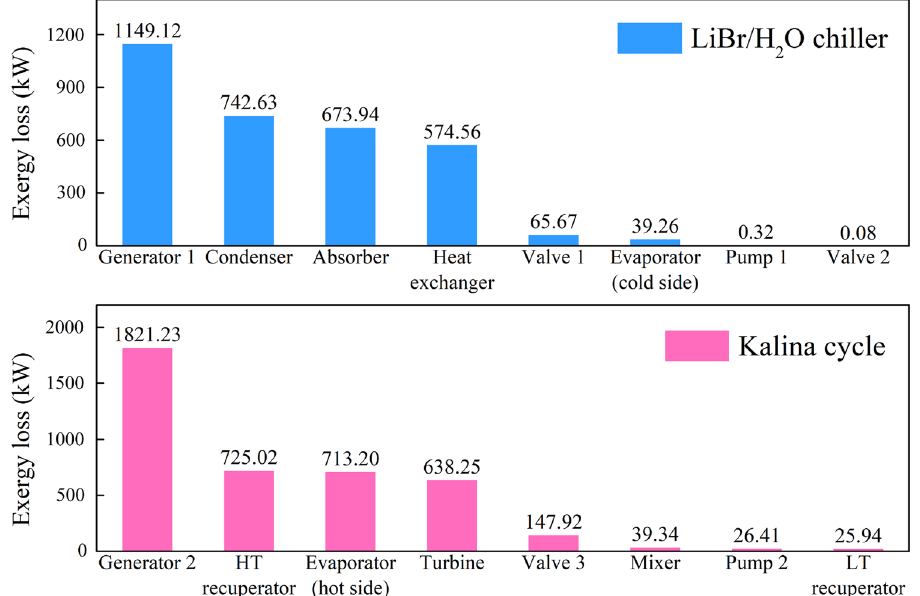
Fig. 6 Exergy loss distribution of both